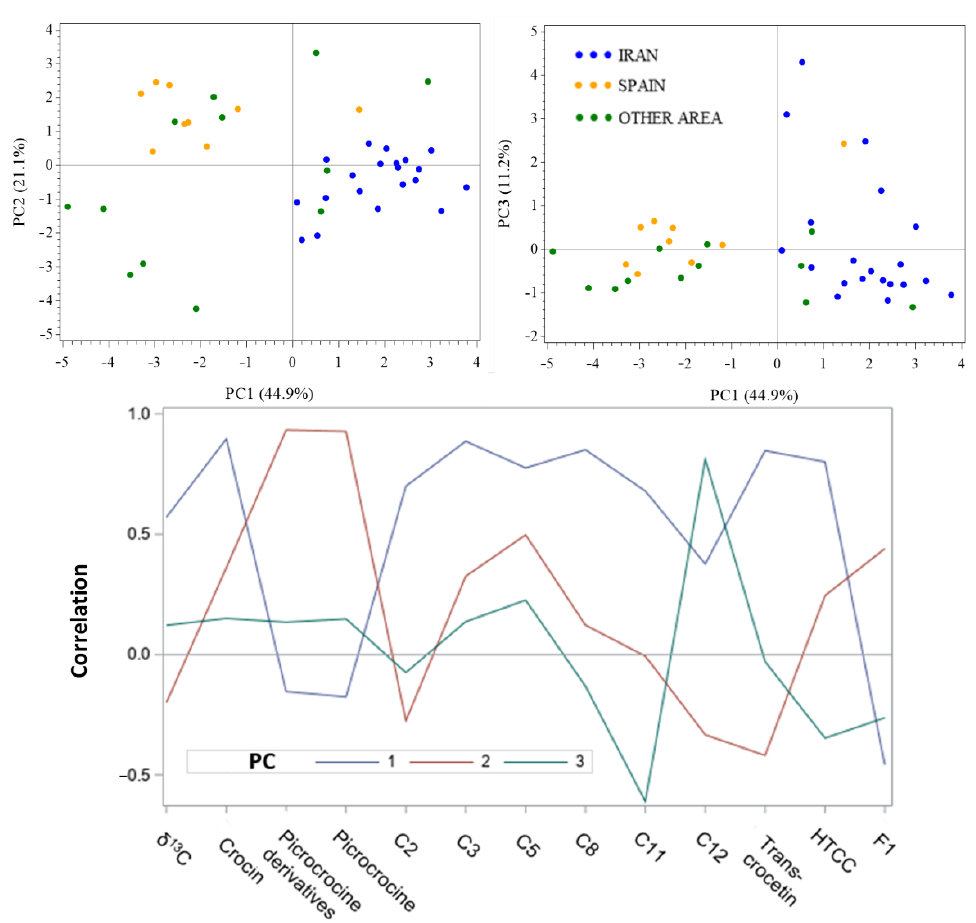
Figure 2. Saffron samples projected in the space of the 3 PC ( above ) and PC pattern profile ( below ).